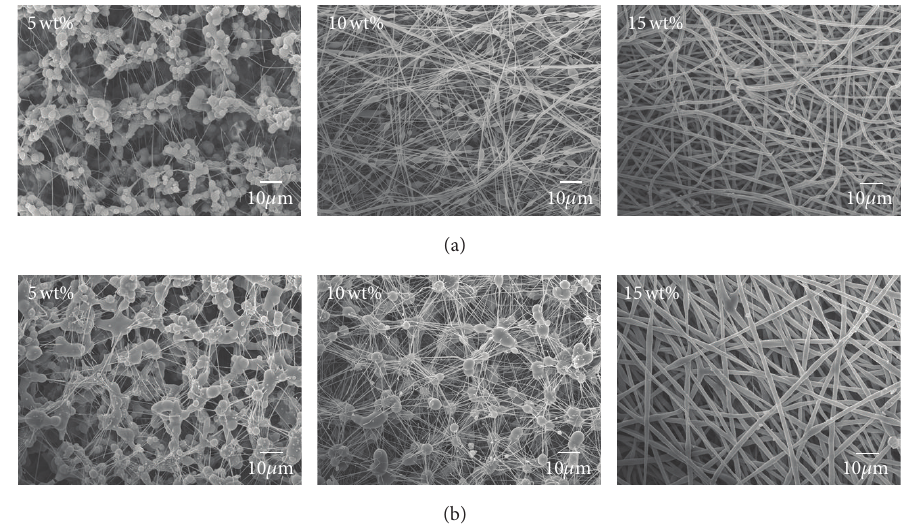
Figure 2: FE-SEM images showing the morphology of fibrous PDLLA prepared with varying solution concentrations. (a) PDLLA-R; (b) PDLLA-COOH.